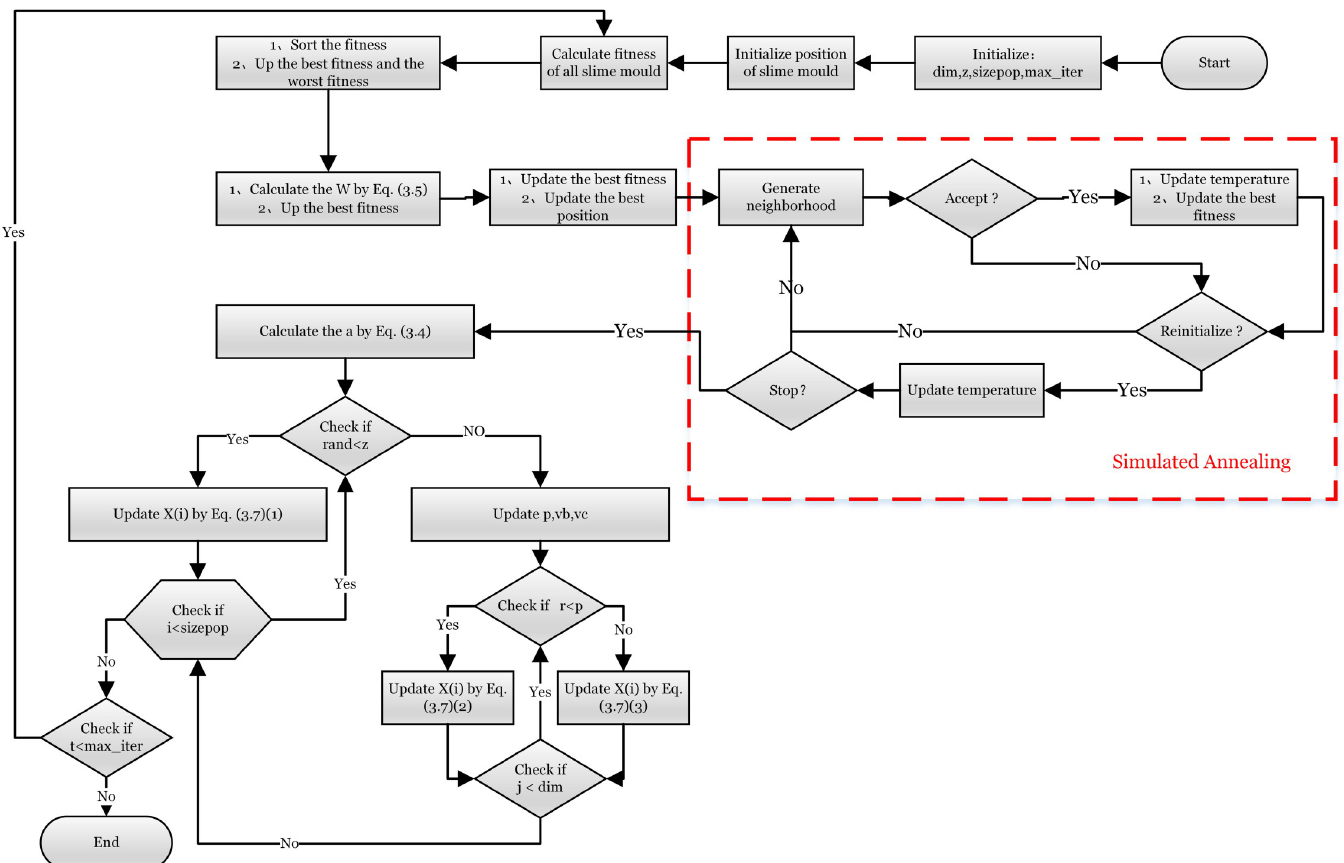
Fig 2. Flowchart of SMA-CSA. The annealing mechanism is in the red dotted box.